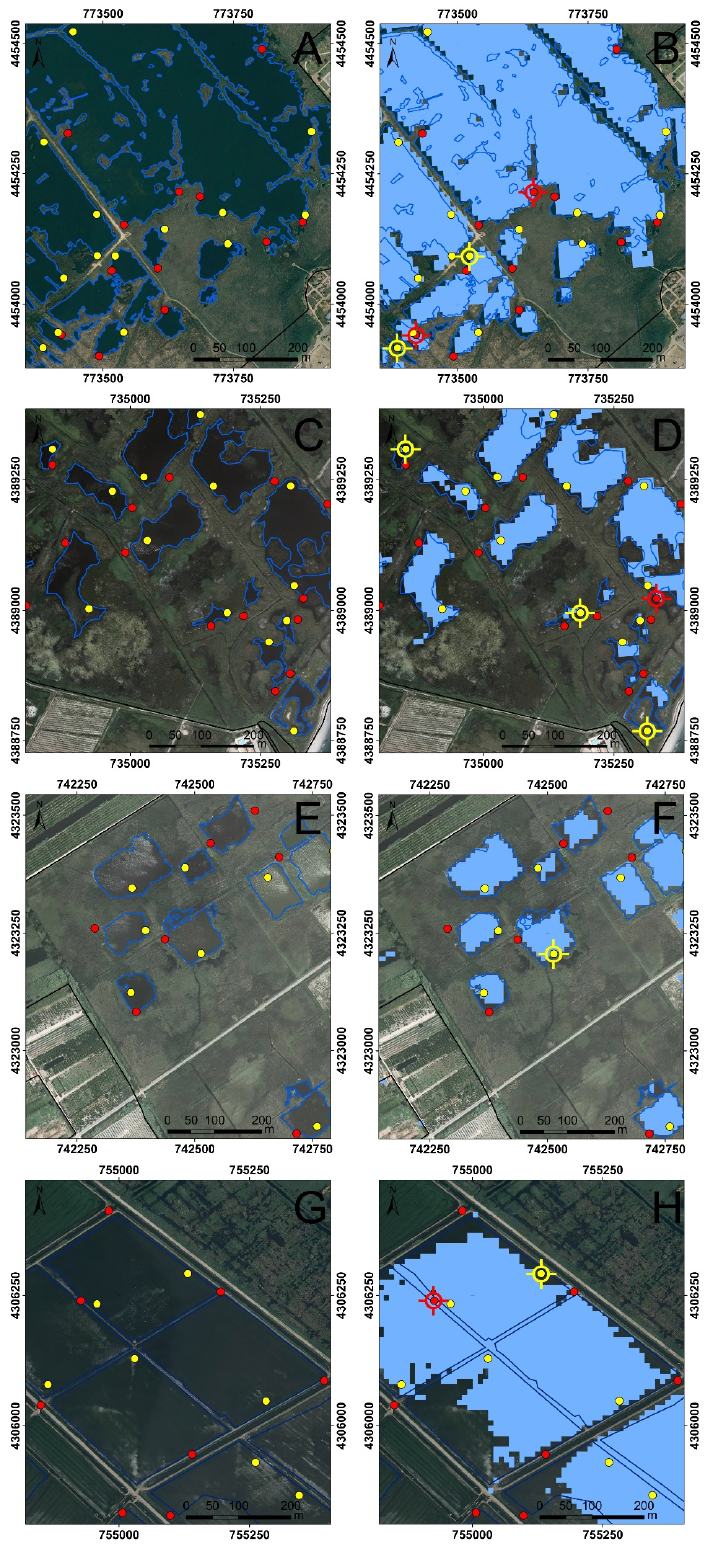
Figure 8. Delimited wetland bodies of water in blue color outline ( A , C , E , G ) versus the result of the NDWI index for the threshold − 0.30 in light blue ( B , D , F , H ). Water sampling points in yellow and non-water in red. False negatives and false positives are marked. ( A , B ): Prat Cabanes-Torreblanca wetland (2018), ( C , D ): Sagunto wetland (2017), ( E , F ): La Safor wetland (2017) and ( G , H ): Pego-Oliva wetland